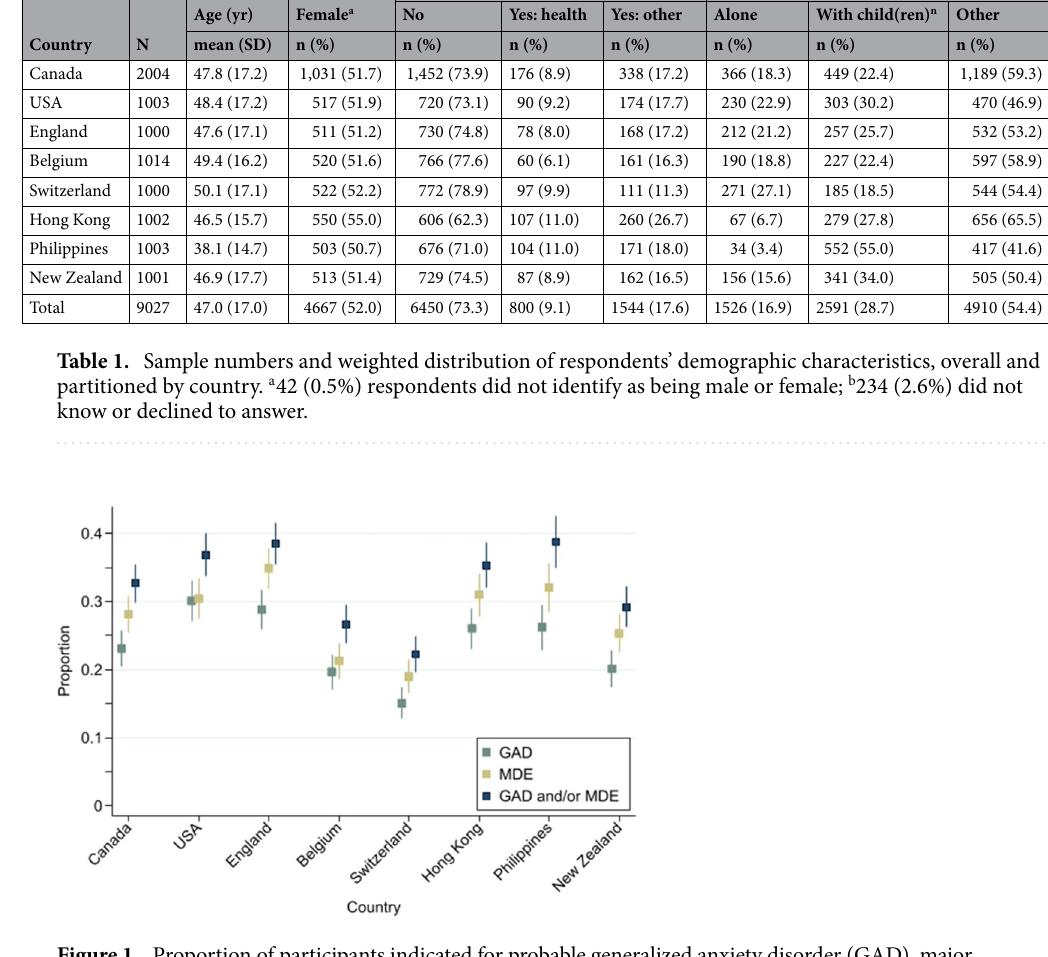
Figure 1. Proportion of participants indicated for probable generalized anxiety disorder (GAD), major depression episode (MDE), and GAD and/or MDE, together with associated 95% confidence intervals (CIs) for the eight participating